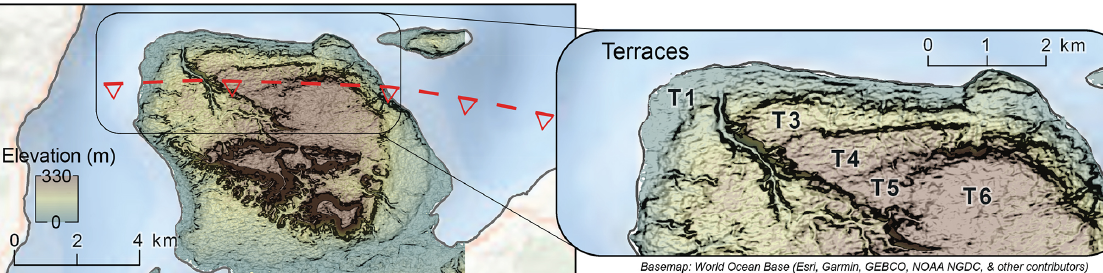
Figure 2. Six coastal terraces (T1–T6) identified using a digital elevation model (DEMNAS) in northwest Bali, likely uplifted due to slip on the Flores Thrust ramp. The location is shown as a green rectangle on the map in Fig. 1b. Basemap – World Ocean